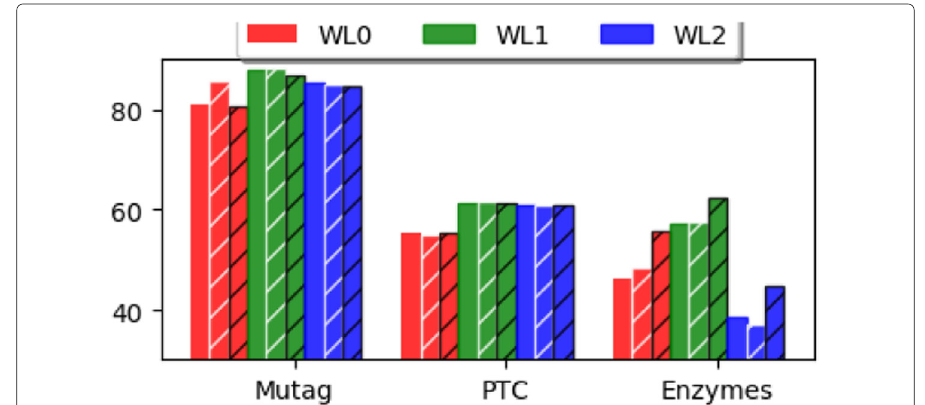
Fig. 10 Substructure granularity (solid: RW, white hatch: BFS, black hatch:SP)